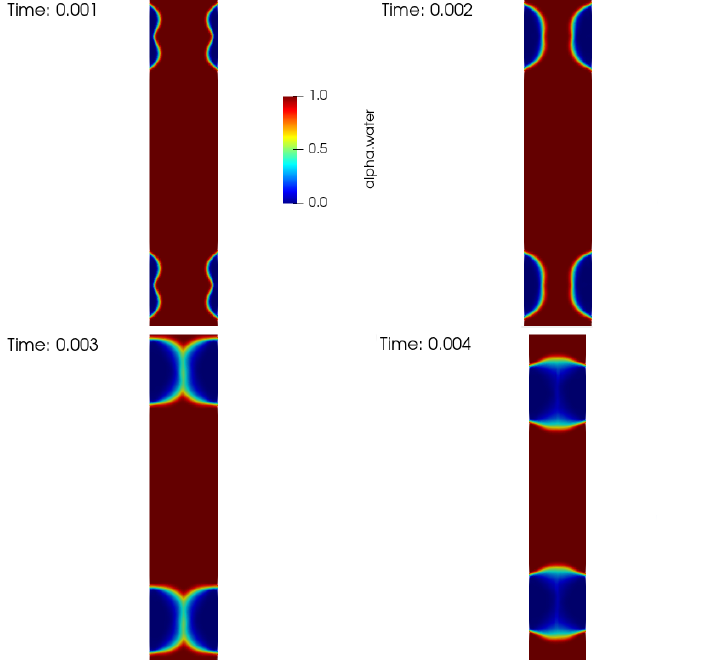
Figure 11. The distribution of ethanol volume fraction (alpha.water) in the evaporator area for the first milliseconds of simulation in the Tanasawa [26] mass transport model for the case of 100 W input